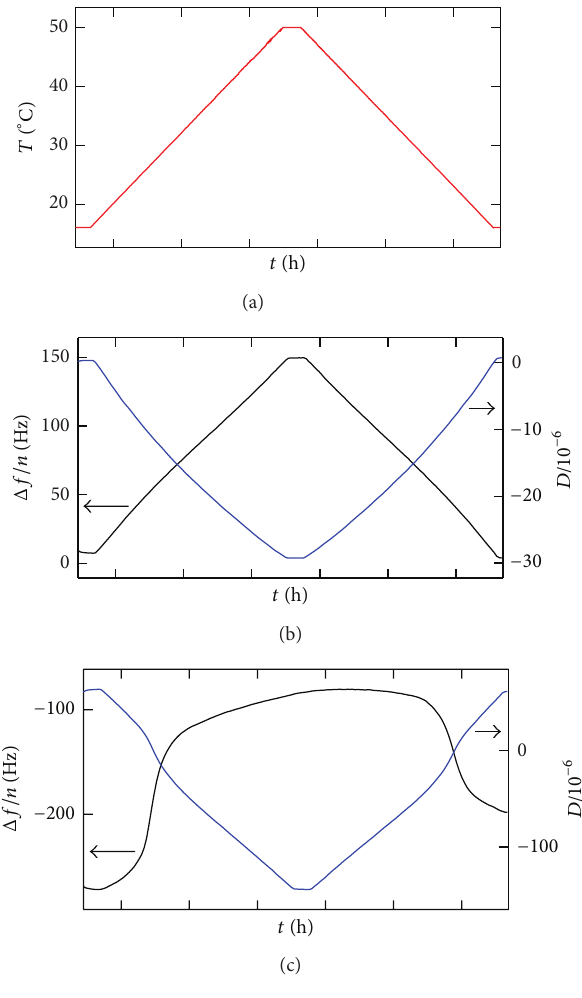
Figure9:(a)Timedependenceofthesensortemperatureduringthe experiments. (b) Δ𝑓/𝑛 (black) and Δ𝐷 (blue) of the 𝑛 = 9 overtone for a blank QCM-D sensor with HEPES buffer. (c) Δ𝑓/𝑛 (black) and Δ𝐷 (blue) of the 𝑛 = 9 overtone for the sensor with HEPES buffer and vesicles adsorbed; data for the DMPC + 0.1 DSPC mixture.